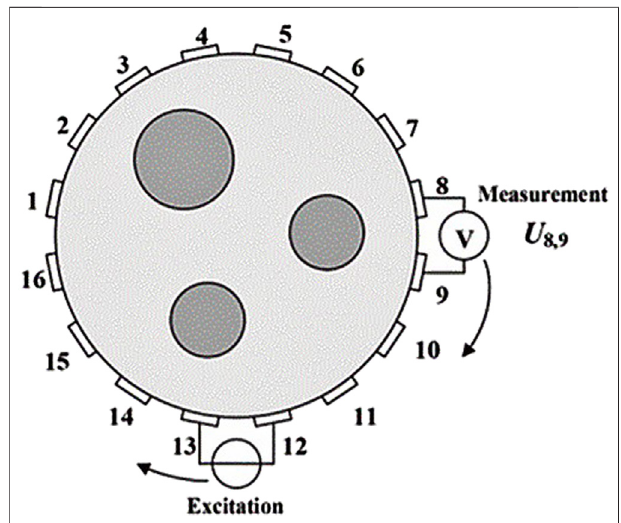
FIGURE 4 | Working principle of a 16 electrode system (Wang et al., 2020). Adjacent excitation is to select a pair of adjacent electrodes to input safe current, and then measure the output voltage between several pairs of adjacent electrodes except the excitation